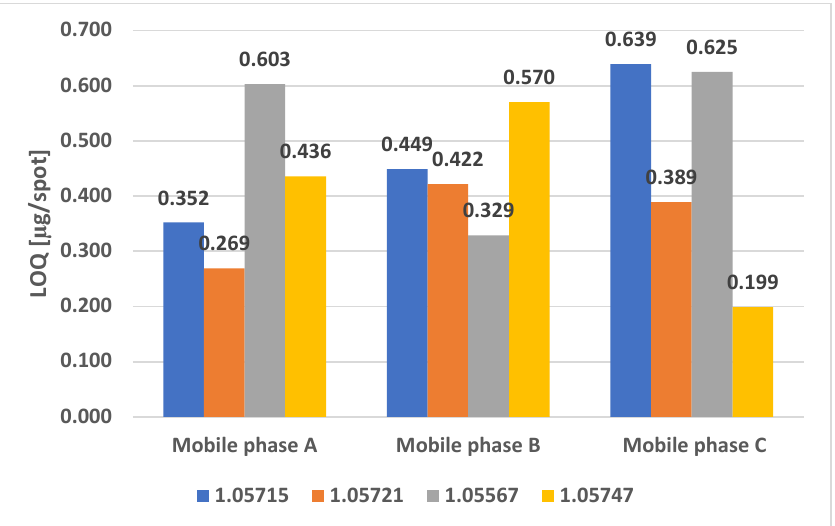
Figure 3. Mean values of the limit of quantification of fluoxetine obtained by NPTLC, where the mobile phases were as follows: A—chloroform + methanol + ammonia, 9:1:0.4 ( v/v/v ); B—chloroform + methanol + glacial acetic acid, 5:4:1 ( v/v/v ); C—acetone + toluene + ammonia, 10:9:1 ( v/v/v ). The chromatographic plates were: 1.05715—silica gel 60 F 254 on glass plates; 1.05721—silica gel 60 on glass plates; 1.05567—mixture of silica gel 60 and kieselguhr F 254 on aluminum plates; 1.05747—silanized silica gel 60 F 254 (RP-2) on glass